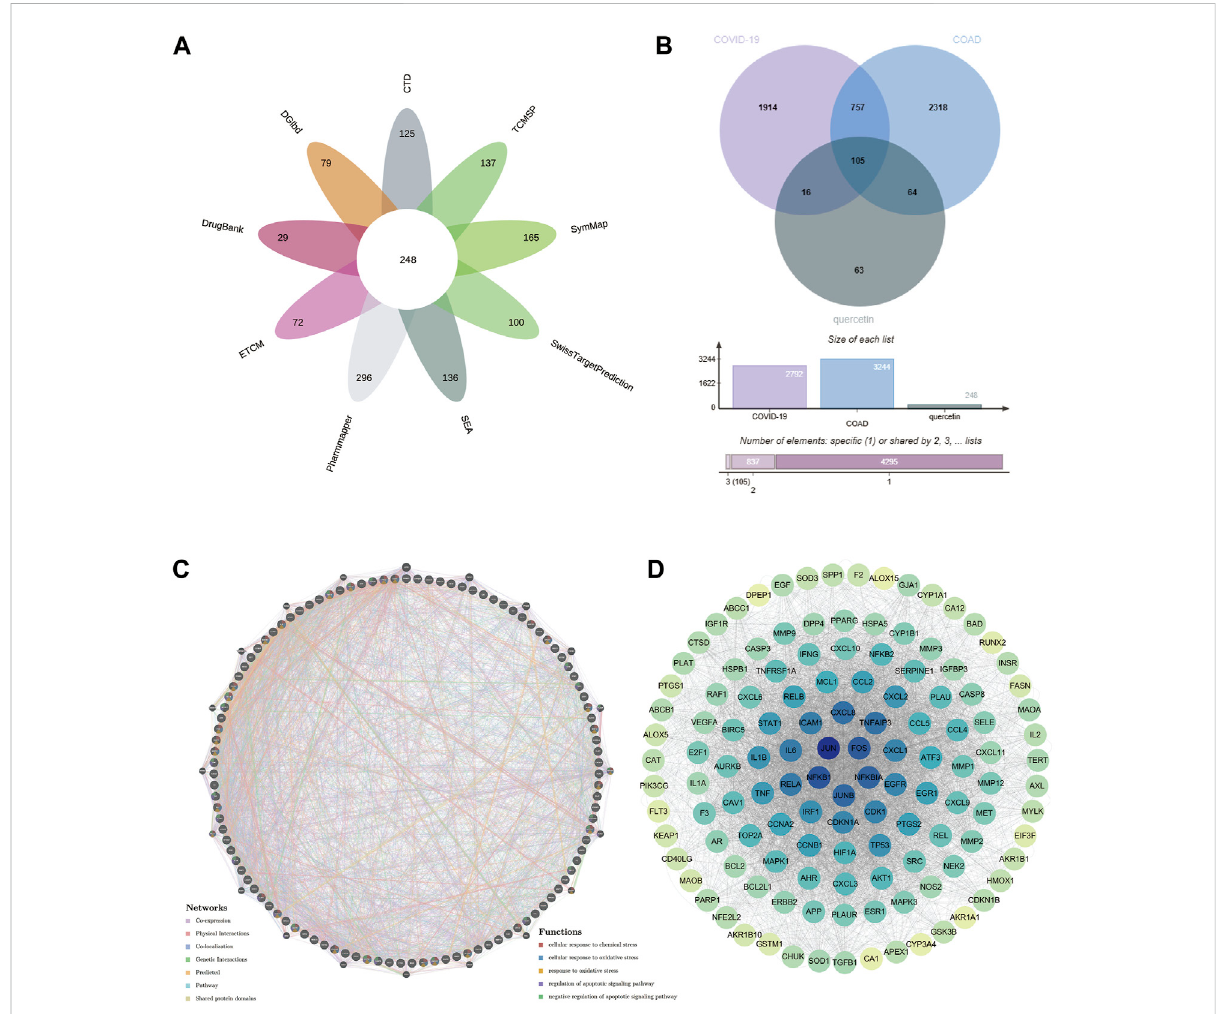
FIGURE 7 Potential target genes of quercetin for the treatment of COAD/COVID-19 and the corresponding PPI network. (A) Target genes of quercetin from 9 databases. (B) Potential target genes of quercetin for the treatment COAD/COVID-19. (C) PPI network of potential target genes. (D) Degree map of the PPI network. COAD: colon adenocarcinoma; PPI: protein-protein